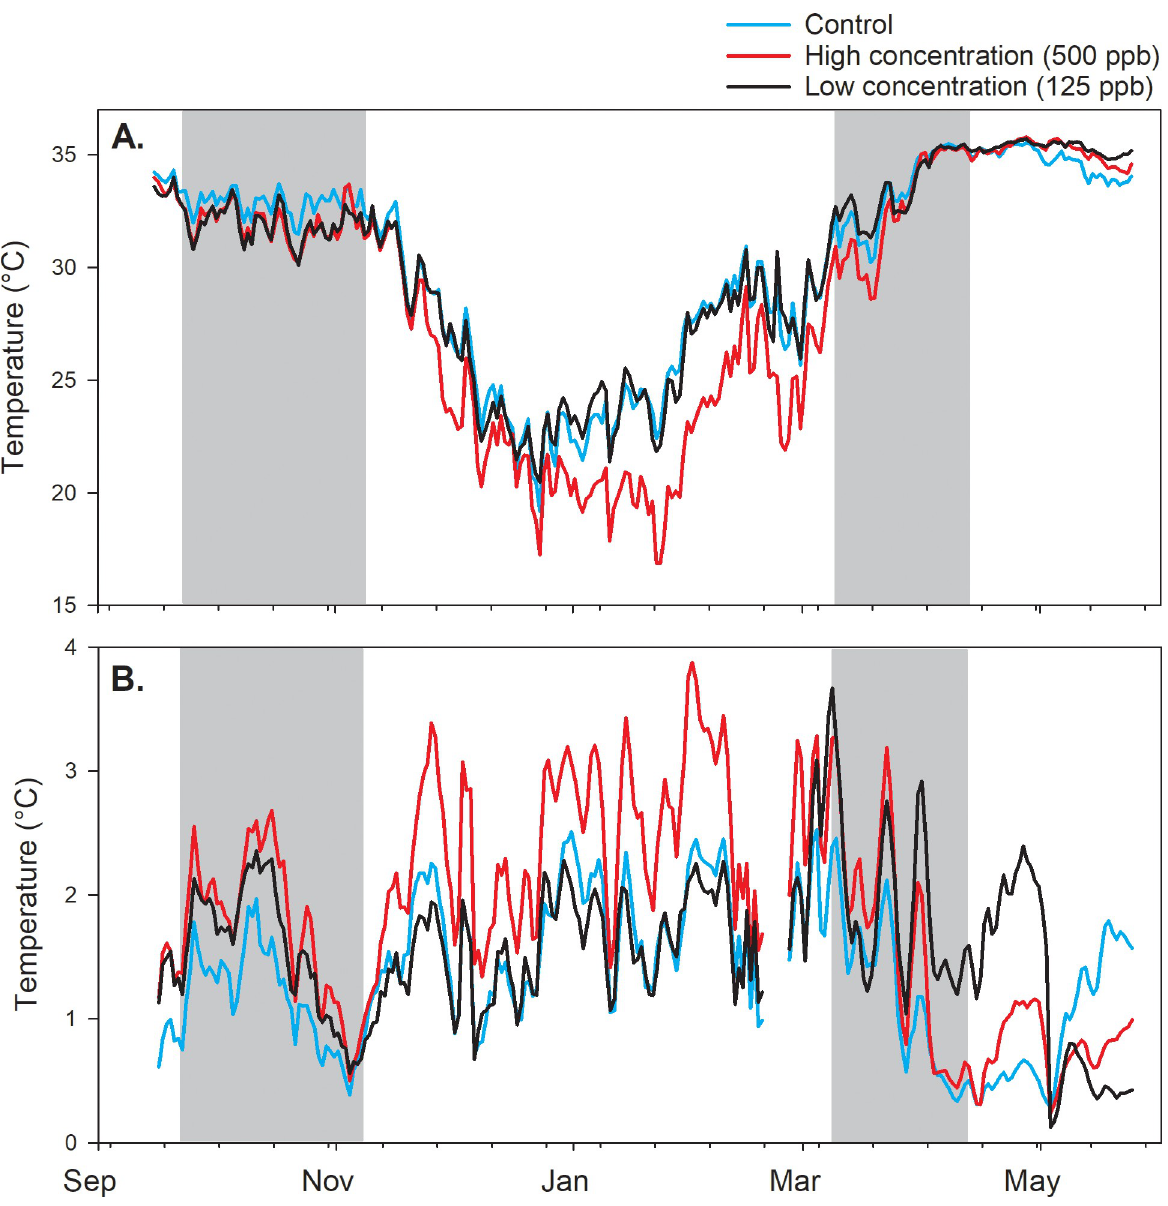
Fig 6. Internal hive temperatures. A) Average temperature for the Fall 2017 experiment through the Spring 2018 experiment; B) Average amplitudes of sine curves fit to internal hive temperature data (temperature variability). Gray zones in A) show the periods of treatment